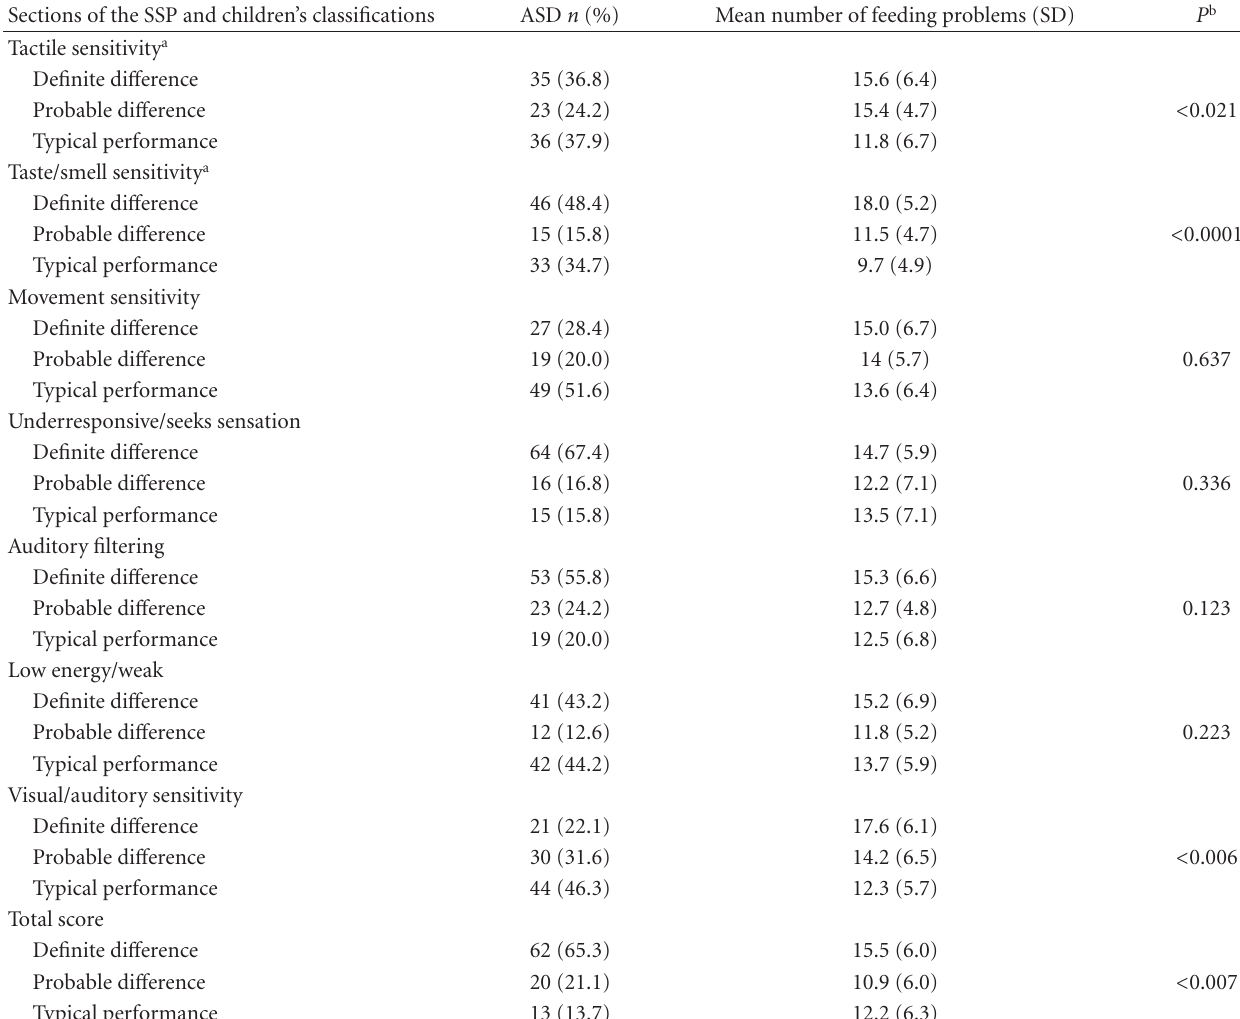
Table 2: Classification of children with ASD, by SSP and mean number of associated eating problems. Sections of the SSP and children’s